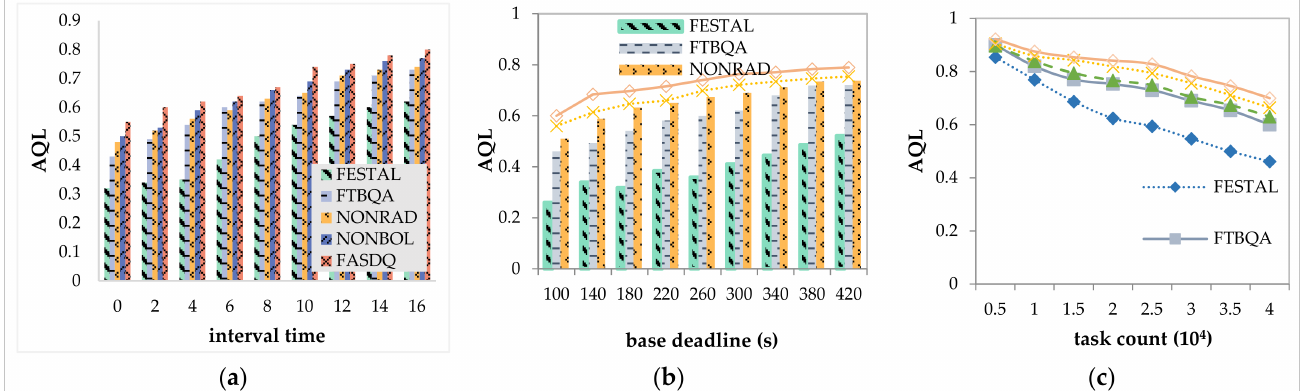
Figure 10. Comparison of average QoS levels (AQL). ( a ) Impact of interval time on AQL; ( b ) impact of base deadline on AQL; ( c ) impact of task count on